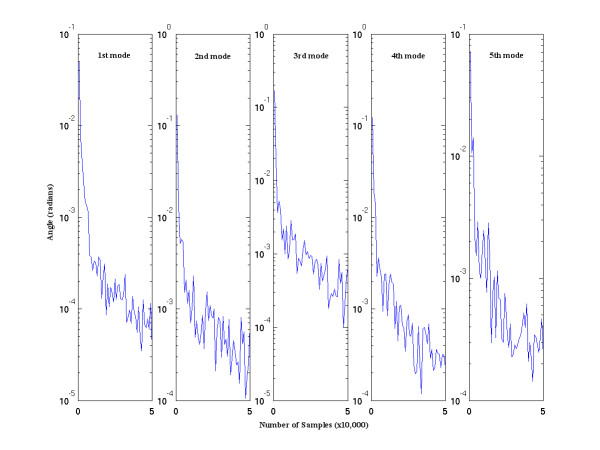
The SVD procedure was applied for increasingly larger sample sizes (up to 1,000,000 in increments of 2,000) and the first five modes at each sample size were recorded. These plots show the convergence of the angle between the modes for subsequent sample sizes.